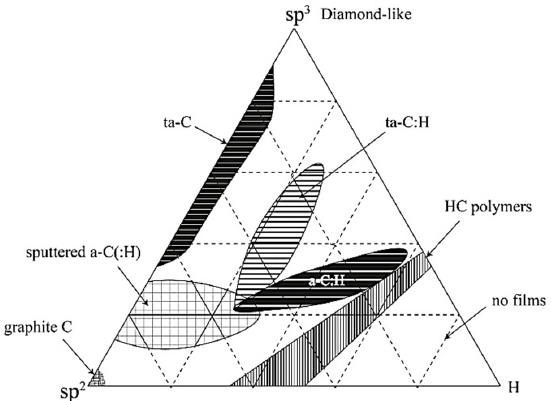
Figure 2. Ternary phase diagram of the C, H system